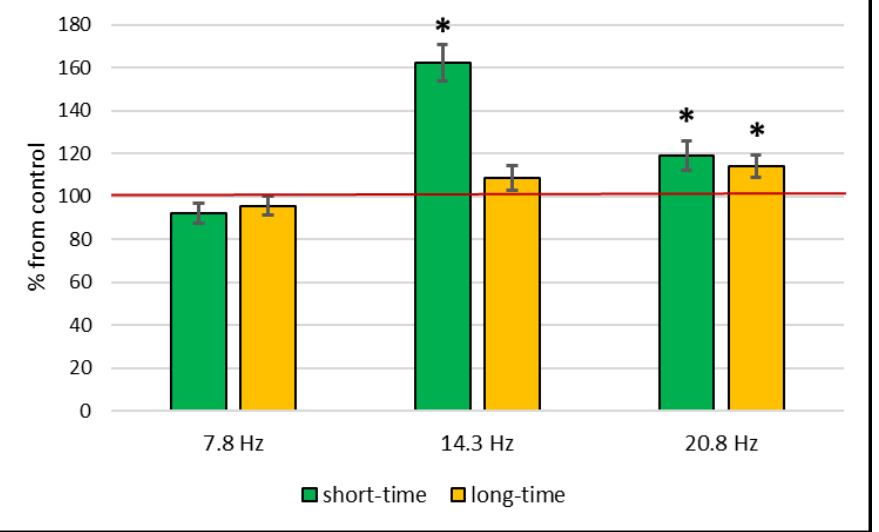
Figure 1. Effect of short-time (30 min) and long-time (18 days) treatment with magnetic fields of different frequencies on catalase activity in wheat plants. Data are represented as mean ± SD. * — a statistically significant difference from control ( p ≤ 0.05); control level taken as 100%. Table 1. Value of redox metabolism parameters of wheat and pea plants after short-time (30 min) and long-time (18 days) exposure to ELF EMF. Data are represented as mean ± SD.